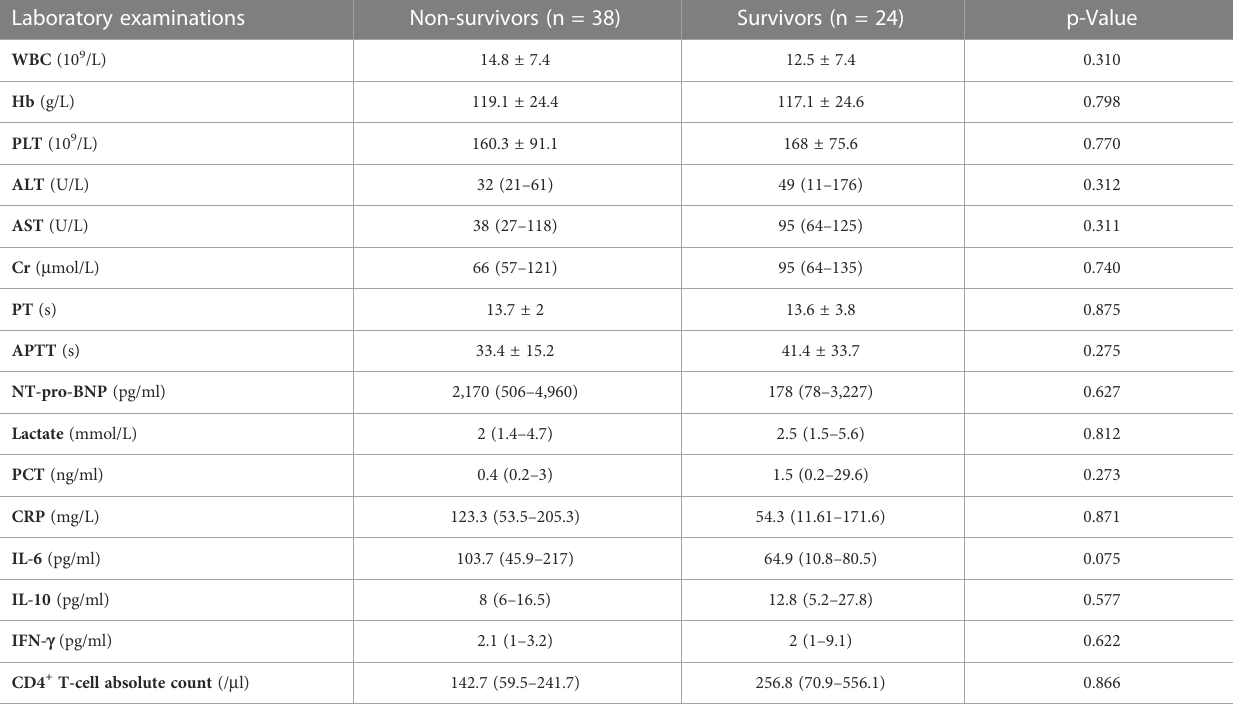
TABLE 2 Baseline laboratory examinations of ECMO